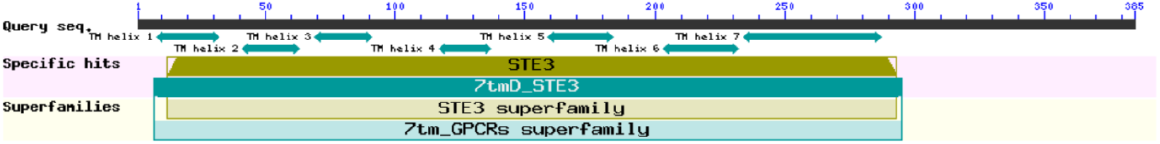
Figure 2. CDD predicts the conserved domain of STE3.3 and STE3.4 protein in Mlp.